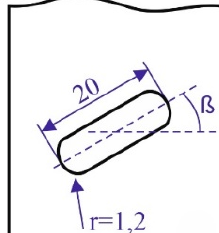
Figure 1. A schematic of centrally located bean-shaped notch with two U-shaped ends (dimensions in mm).